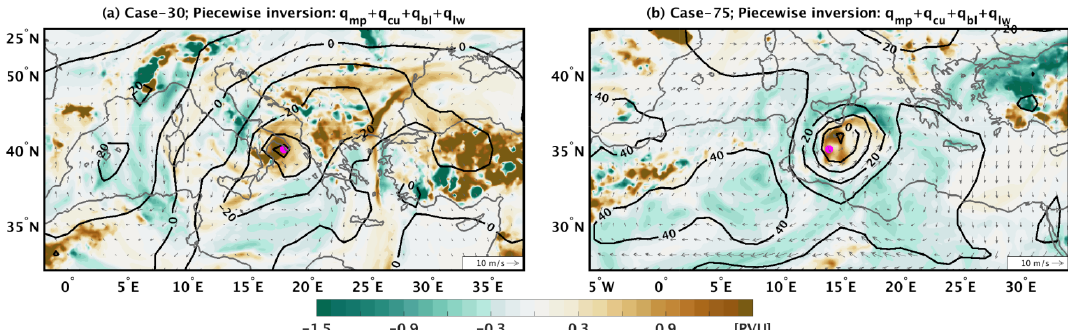
Figure 13. (a) The field of q mp + q cu + q bl + q lw at 850hPa (colour) and the balanced wind (arrows) and geopotential height (contours) fields at 850hPa after inverting q mp + q cu + q bl + q lw for cyclone case no. 30. (b) As in (a) but for case no. 75.